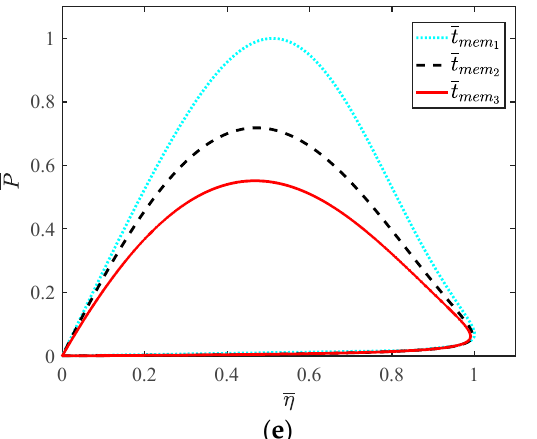
Figure 9. The relationship between power density and thermal efficiency: ( a ) T ; ( b ) p ; ( c ) RH ; ( d ) DL ; ( e ) t mem .